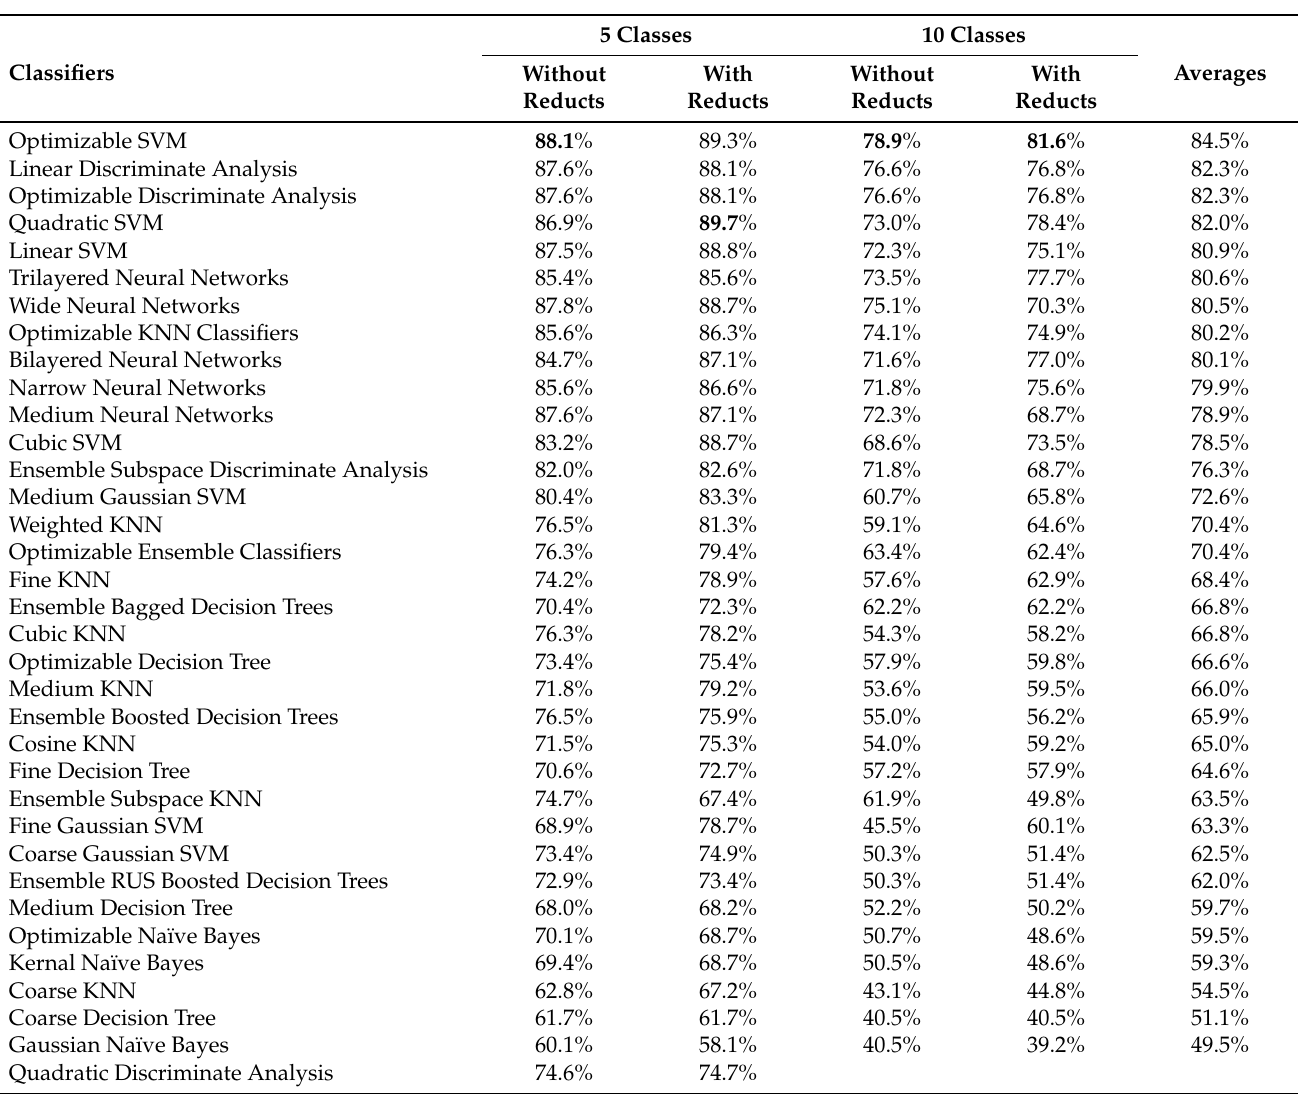
Table 6. Class prediction rates of the KAU